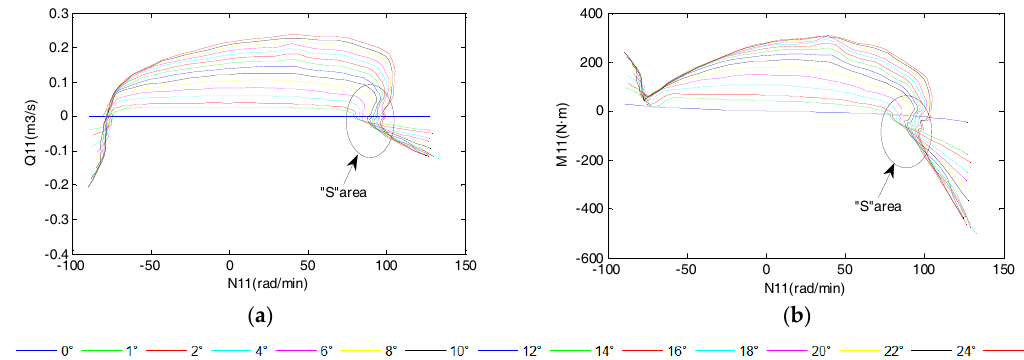
Figure 3. Characteristic curve of a pump-turbine. ( a ) flow characteristic curve; and ( b ) torque characteristic curve.